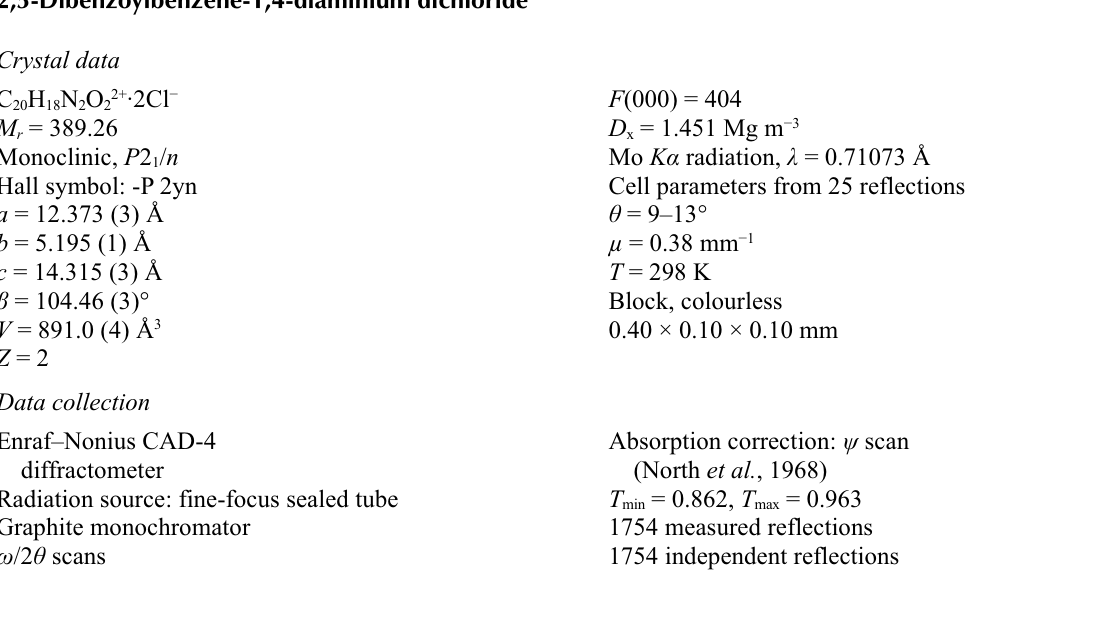
Crystal packing of the title compound. Hydrogen bonds are shown as dashed lines. 2,5-Dibenzoylbenzene-1,4-diaminium